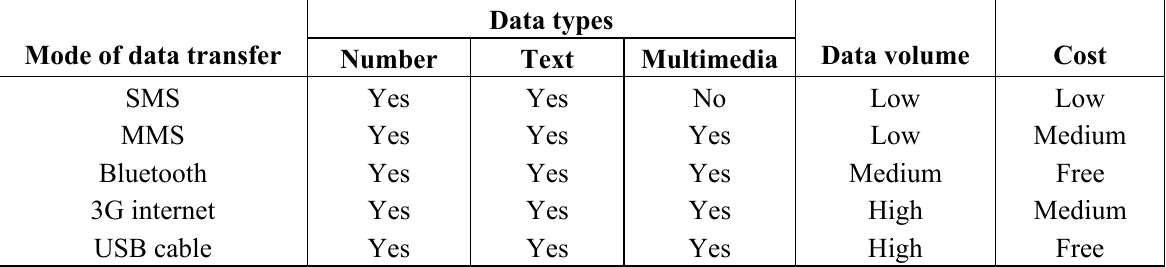
Table 1. Comparison of Mobile data transmission means (adopted from